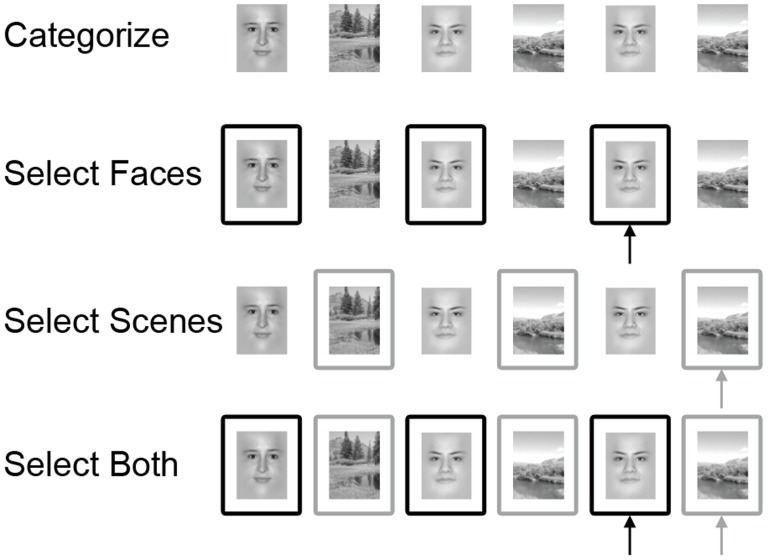
Experimental design of the Selective WM task.All blocks consisted of sequences of 20 stimuli (10 faces and 10 scenes in pseudo-random order), presented one at a time. Black and gray boxes around the stimuli are for illustrative purposes and highlight which trials were relevant for each block. Arrows point to match trials.